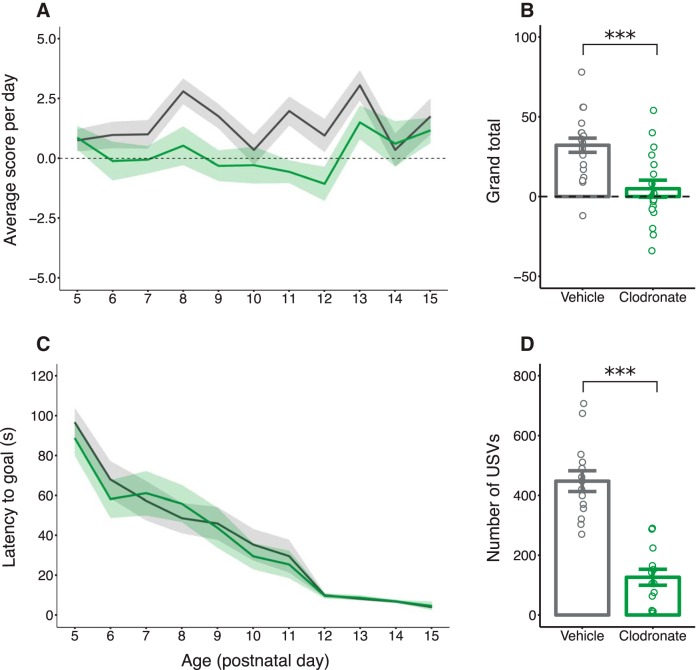
Postnatal microglia depletion impairs nest-seeking behavior and decreases USV emission. Quantification of data from the two-choice nest-seeking task represented as average score per day (a), average total score summed across all testing days (b), and average latency (in seconds) to reach either goal arm of the testing apparatus (c). d, Quantification of the number of USVs produced by pups when separated from the mother on PN8. Solid lines and bars indicate group means for VEH-treated (black) and LC-treated (green) rats of both sexes. Shaded regions and error bars indicate ± SEM. Open circles represent data from individual rats. Horizontal dashed line indicates score equal to chance (a, b). ***p < 0.001. n = 18–20 (a–c) and 13–14 (d) per treatment.